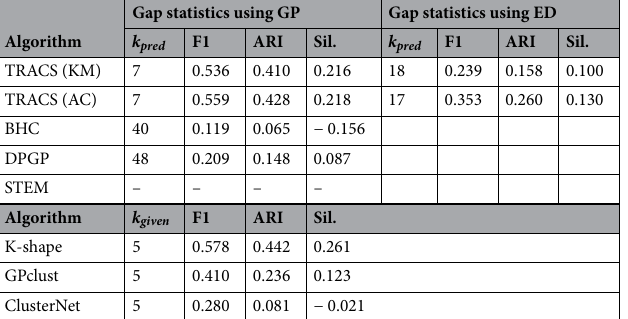
Table 1. Optimal number of clusters ( k pred ) inferred from cell cycle dataset ( k true =5) with a given range of [1, 20] and clustering performance evaluation with inferred k pred . As K-shape, GPclust and ClusterNet do not predict the number of clusters, the true number of clusters is given ( k given = k true ). ( F1 F1 score, ARI